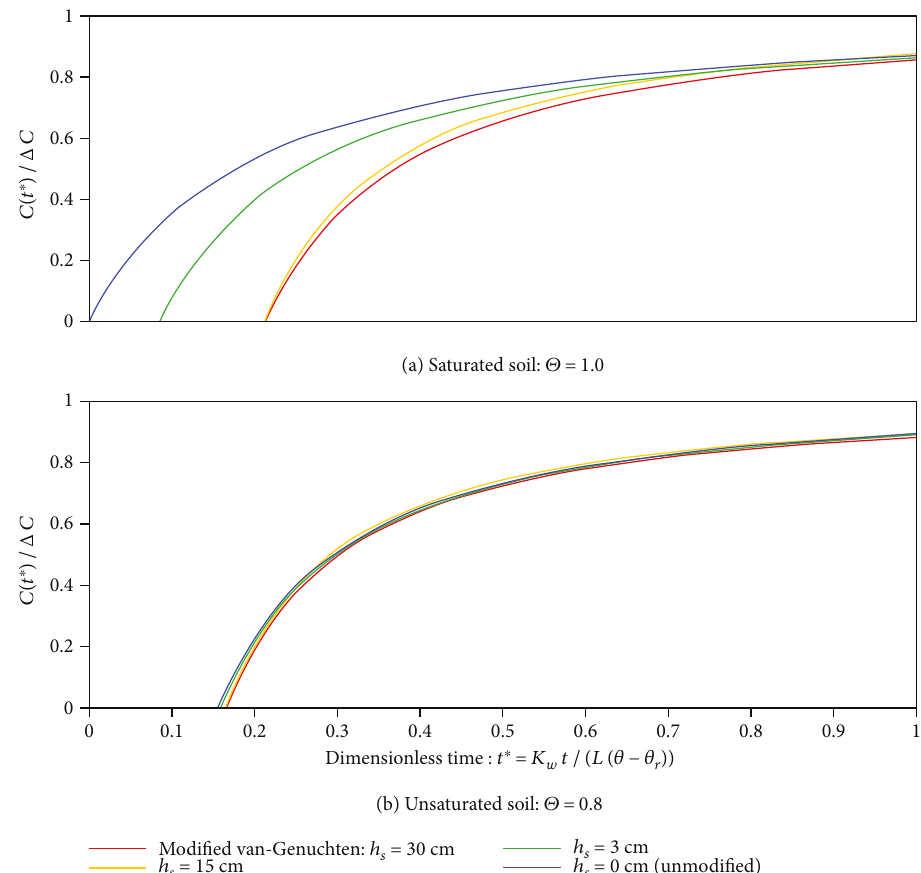
Figure 5: E ff ect of air entry pressure and e ff ective saturation on breakthrough curves for sandy loam soil in the (a) unmodi fi ed Mualem-van Genuchten model and (b) the modi fi ed Mualem-van Genuchten model.